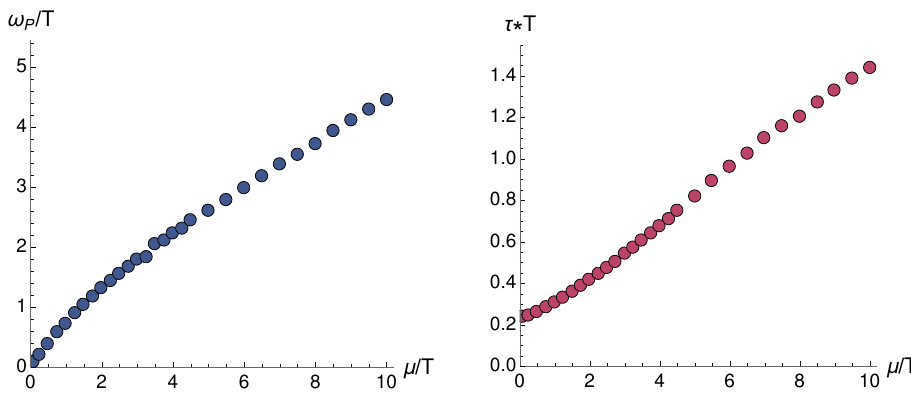
Figure 7 . Evolution of ! P and (cid:28) with increasing (cid:22)=T for (cid:21) = 1 obtained from the (cid:12)ts as shown in (cid:12)gure